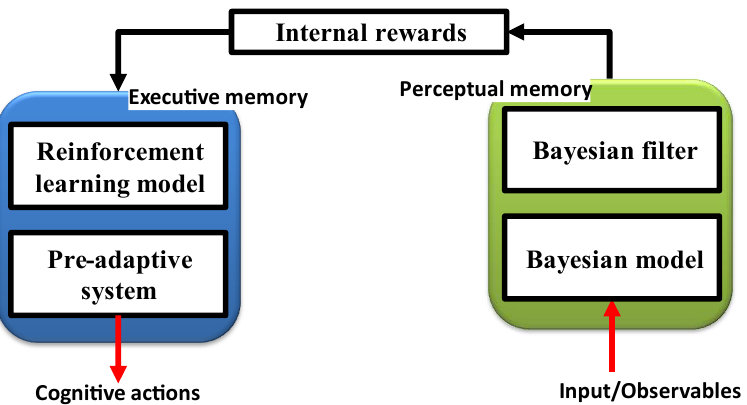
Figure 4. The functional brain-like block in the cognitive dynamic system that controls executive and perceptual memory. (CDS: cognitive dynamic system.)